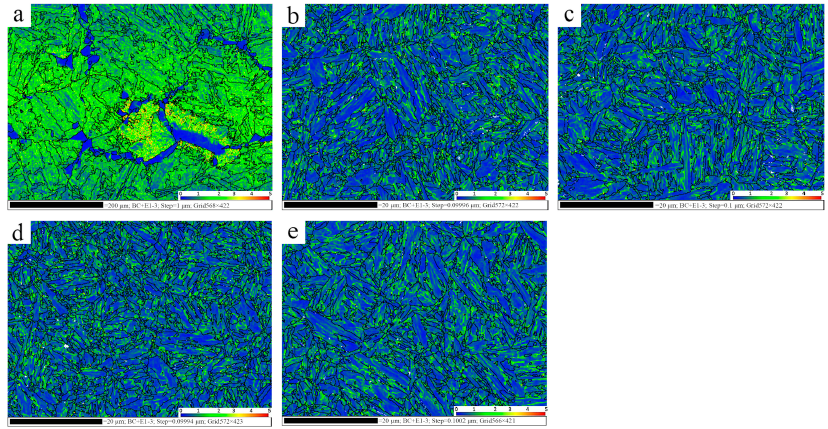
Figure 16. The local misorientation maps for ( a ) BM, ( b ) HDL, ( c ) HDT, ( d ) CFL, and ( e )